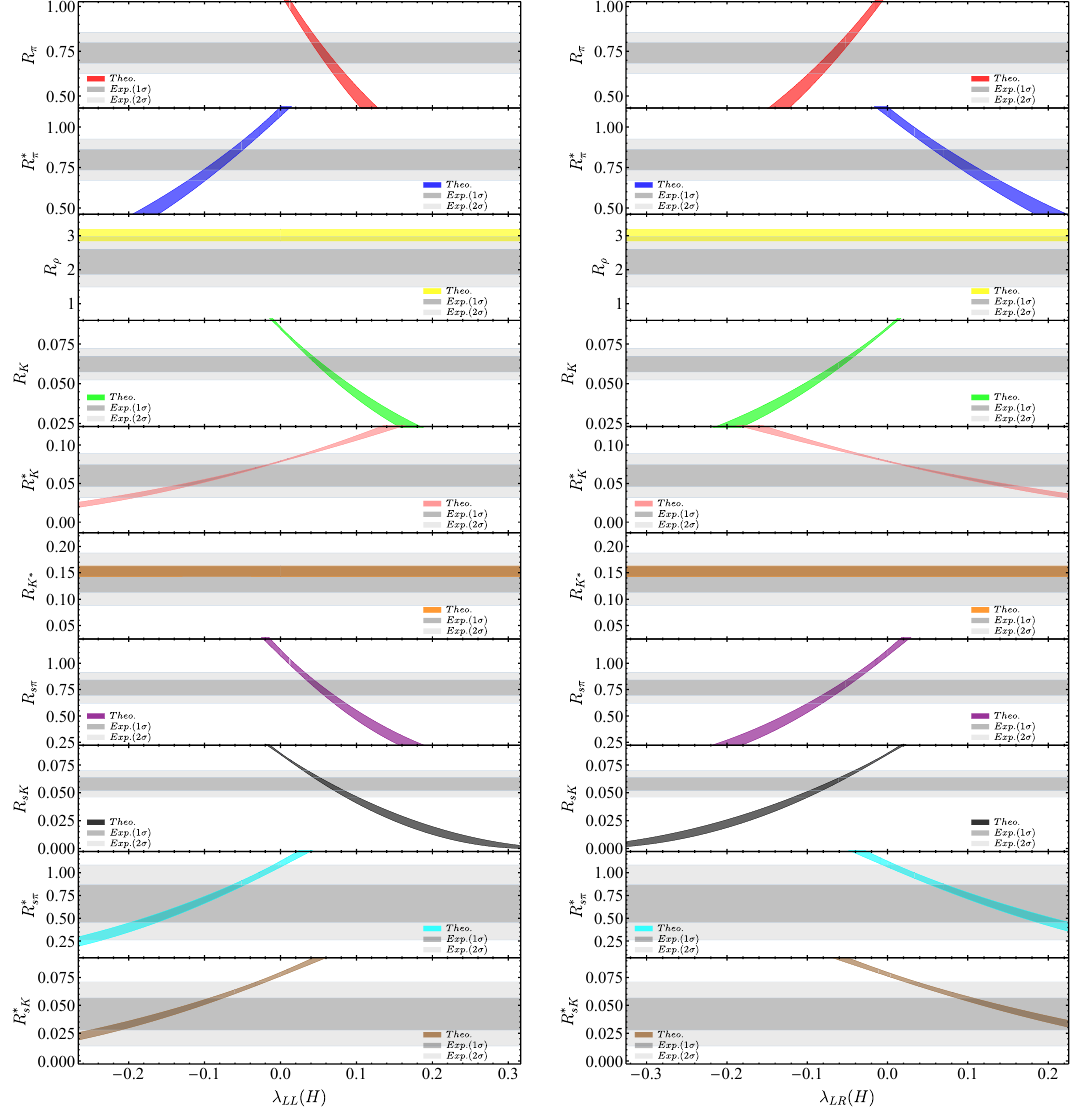
Figure 20 . Constraints on the effective coefficients λ LL ( H ) (left) and λ LR ( H ) (right) from the ratios R ( ∗ ) collected in table 6. The other captions are the same as in figure ( s ) L